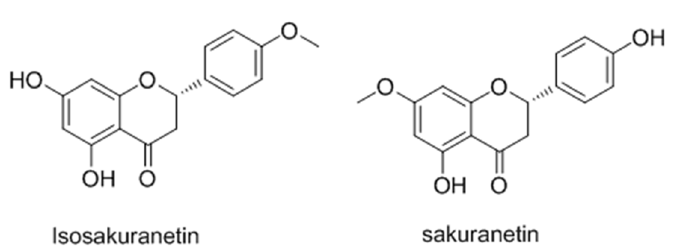
Figure 6. Structures of isosakuranetin and sakuranetin.